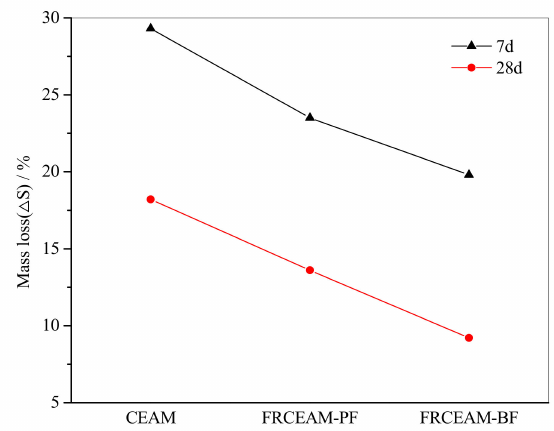
Figure 5. Cantabro raveling losses of CEAM and